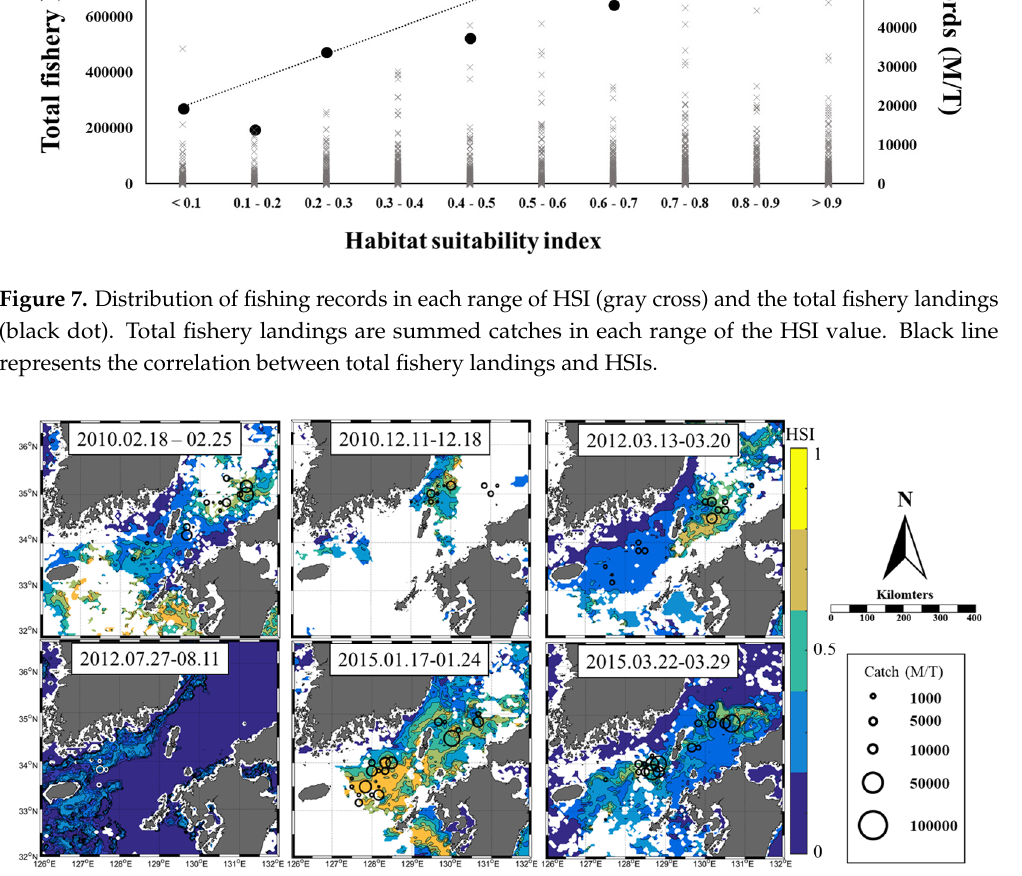
Figure 8. Spatial distribution of the 8-day composited HSI and the chub mackerel catches at corresponding periods in the South Sea.